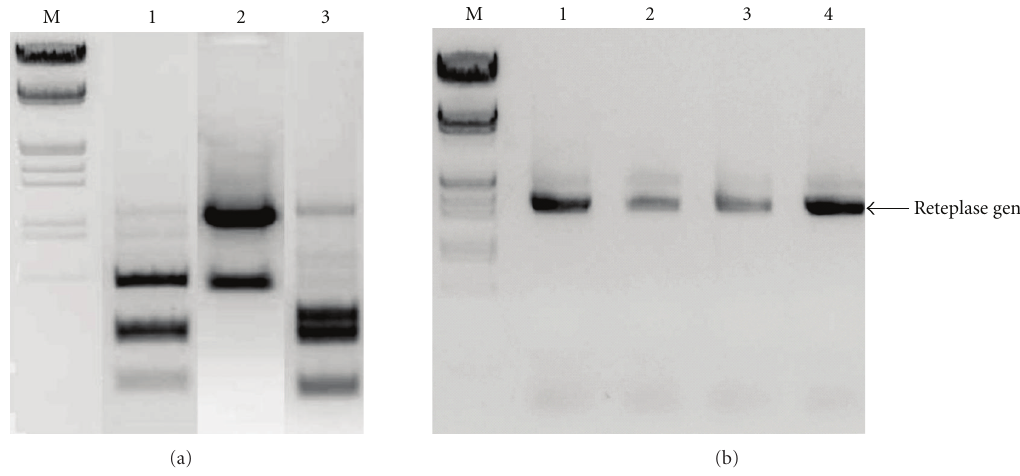
Figure 2: (a) Restriction analysis of the PCR product of pPIC9K-rPA mutated constructs. M: lambda EcoR1 / HindIII digest, lane 1: PCR product from N12P clone+ Sma1 ; lane 2: N278S clone+ XbaI ; lane 3: N12P, N278S + Xba1/Sma1 . (b) Integration PCR of Pichia recombinants carrying native rPA gene. M: lambda EcoR1 / HindIII digest; lanes 1–4 geneticin resistant clones of Pichia carrying ppIC9K-reteplase gene and its mutants integrated into its genome. Lane 1: N12P clone; lane 2: N278S; lane 3; N12P, N278S; lane 4: WT reteplase.